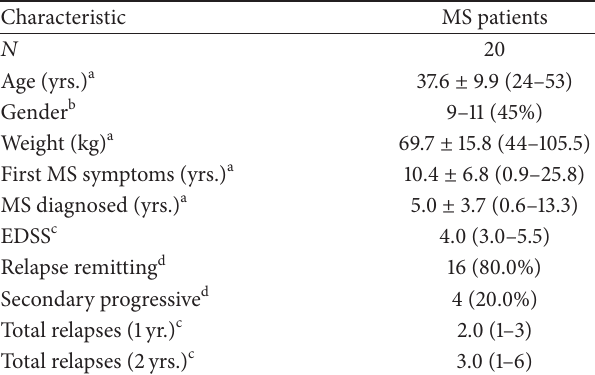
Table 1: Patients’ baseline